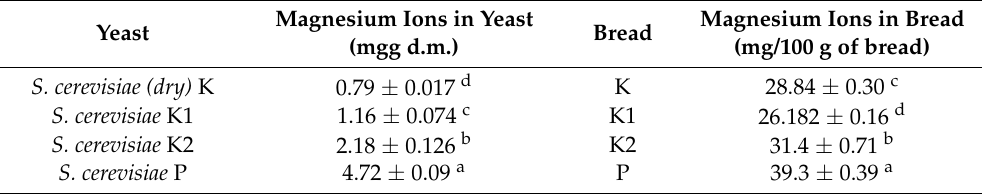
Table 1. Magnesium in S. cerevisiae cells and bread with S. cerevisiae supplemented with magnesium ions. Control samples: K, dry yeast; K1, without magnesium and PEF treatment; K2, with magnesium and without PEF treatment; P, with magnesium and PEF.